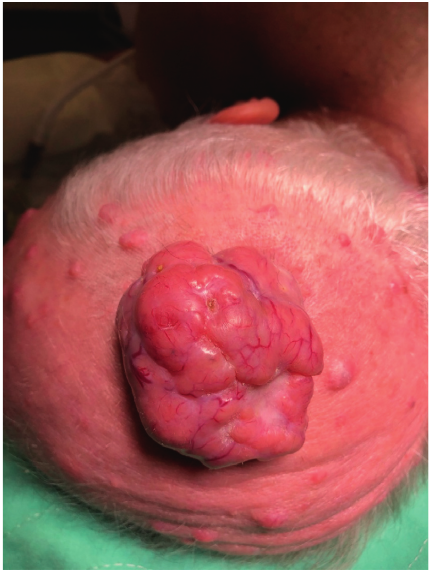
Figure 1: Cylindroma presentation on the patient’s head, before surgical